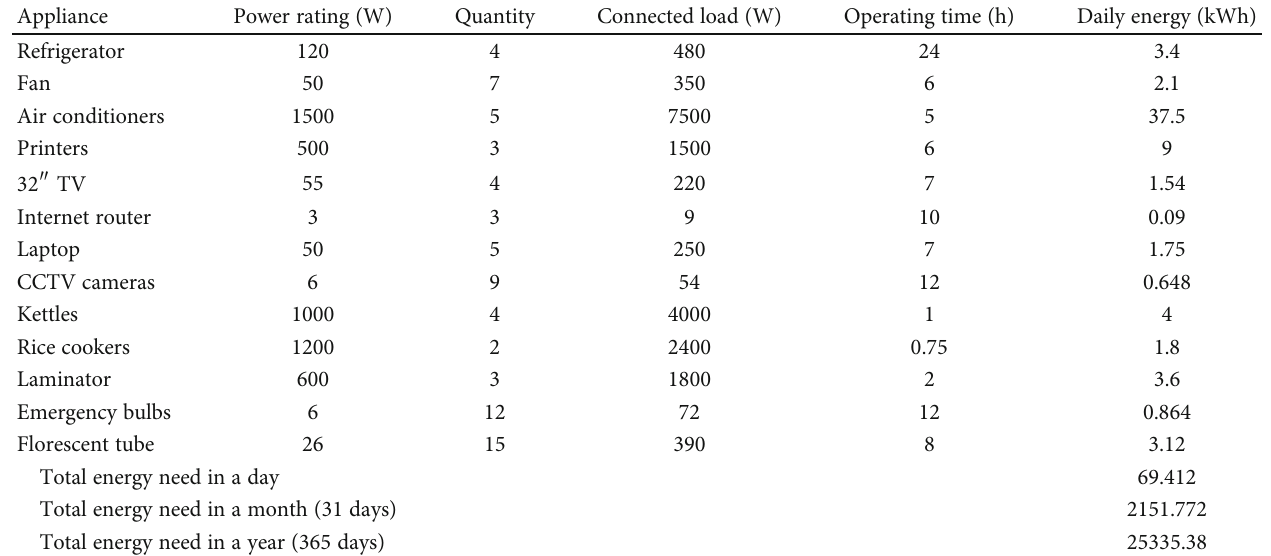
Table 3: Recommended energy use for the